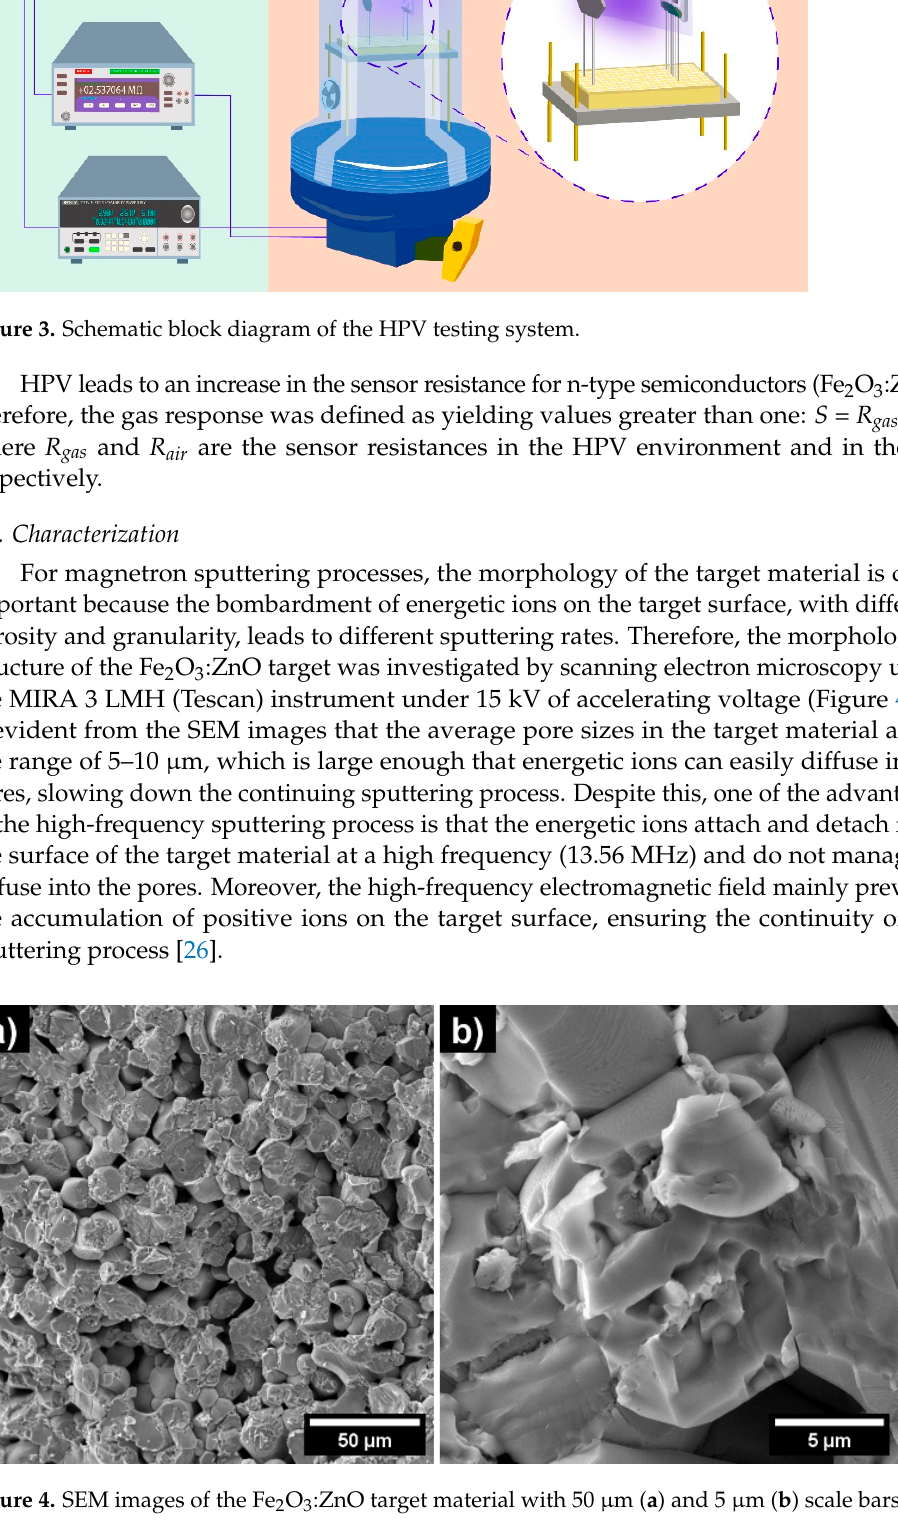
µ m ( a ) and 5 µ m ( b ) scale